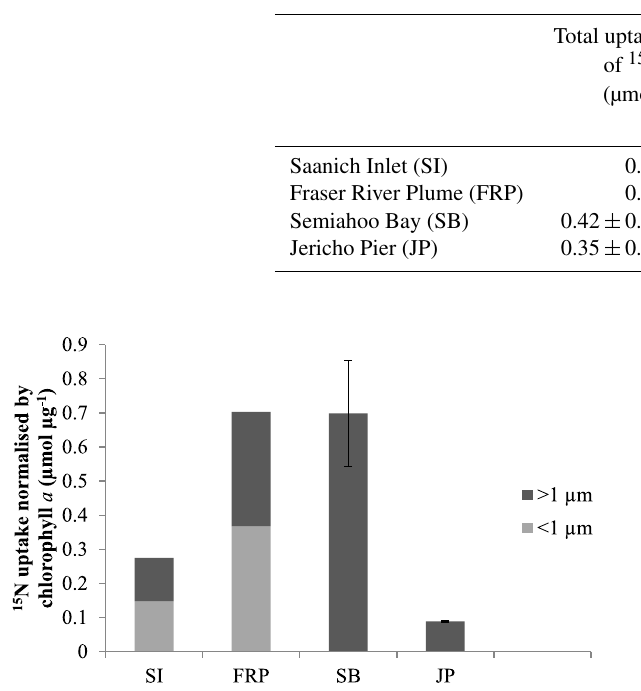
Figure 3. Uptake of 15 N normalised by initial chlorophyll a con- centrations by the >1µm and <1µm fractions in treatments with lysate addition for Saanich Inlet (SI), Fraser River Plume (FRP), Semiahoo Bay (SB), and Jericho Pier (JP). Error bars are standard error of triplicate incubations for SB, and range of duplicate incu- bations for JP. SI and FRP are singleton